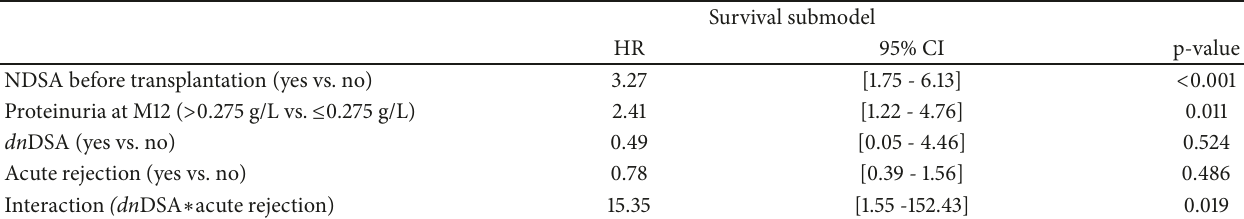
Table 2: Joint latent class mixed model estimates of hazard ratio for graft failure risk.